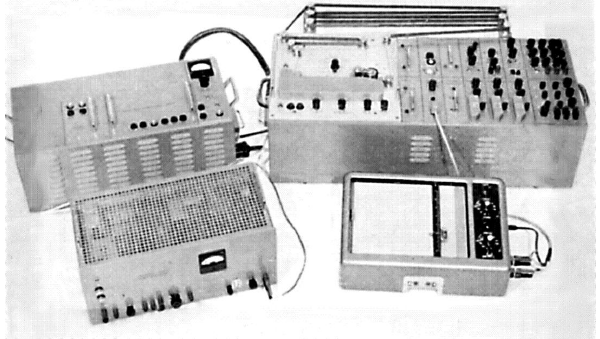
Figure 5: The ISAC